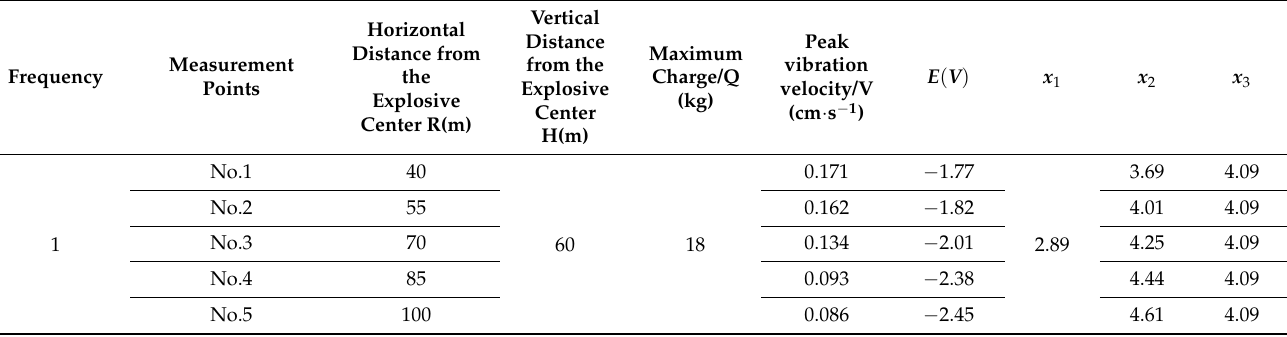
Table 3 is measured and preprocessed blast vibration data. Table 3. Measured and preprocessed blast vibration